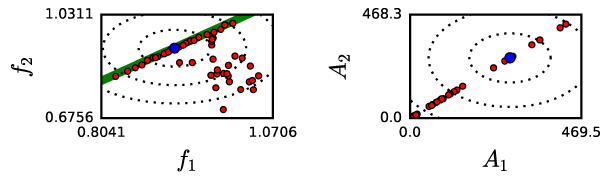
Fig. 10.— Model 9 frequencies ( f 1 ,f 2 ) and amplitudes ( A 1 ,A 2 ) for Table 3 data. Otherwise as in Fig. 4. into decreasing order f (cid:63) > f (cid:63) ... > f (cid:63) . They give ¯ β (cid:63) = 1 2 K 1 I ..., f (cid:63) ] for the simulated g ( t ) model (Eq. 1). [ f (cid:63) , f (cid:63) 1 2 K 1 , C (cid:63) , ..., The K 1 × 2 K 2 values for the amplitudes B (cid:63) 1 , 1 1 , 1 B (cid:63) , C (cid:63) of the simulated h i ( t ) signals, as well as K 1 ,K 2 K 1 ,K 2 the K 3 + 1 values for the coefficients M (cid:63) , ..., M (cid:63) of the 0 K 3 simulated p k ( t ) polynomials, are drawn from a uniform random distribution